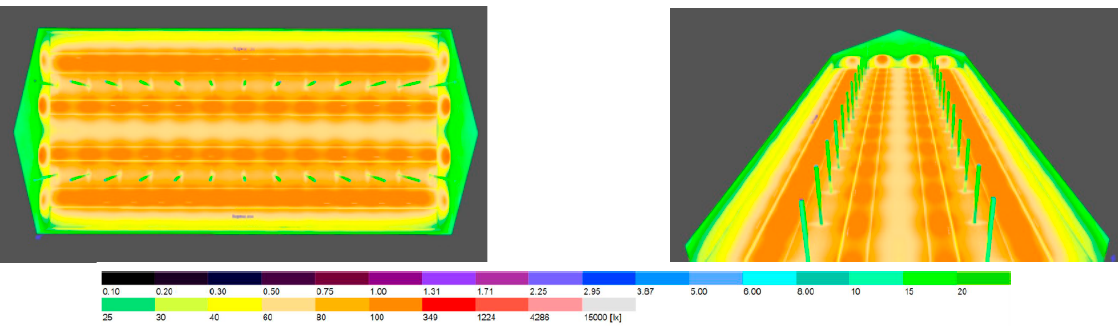
Figure 5. Modeled calculated distribution of illumination inside the cowshed using 56 LED lamps.